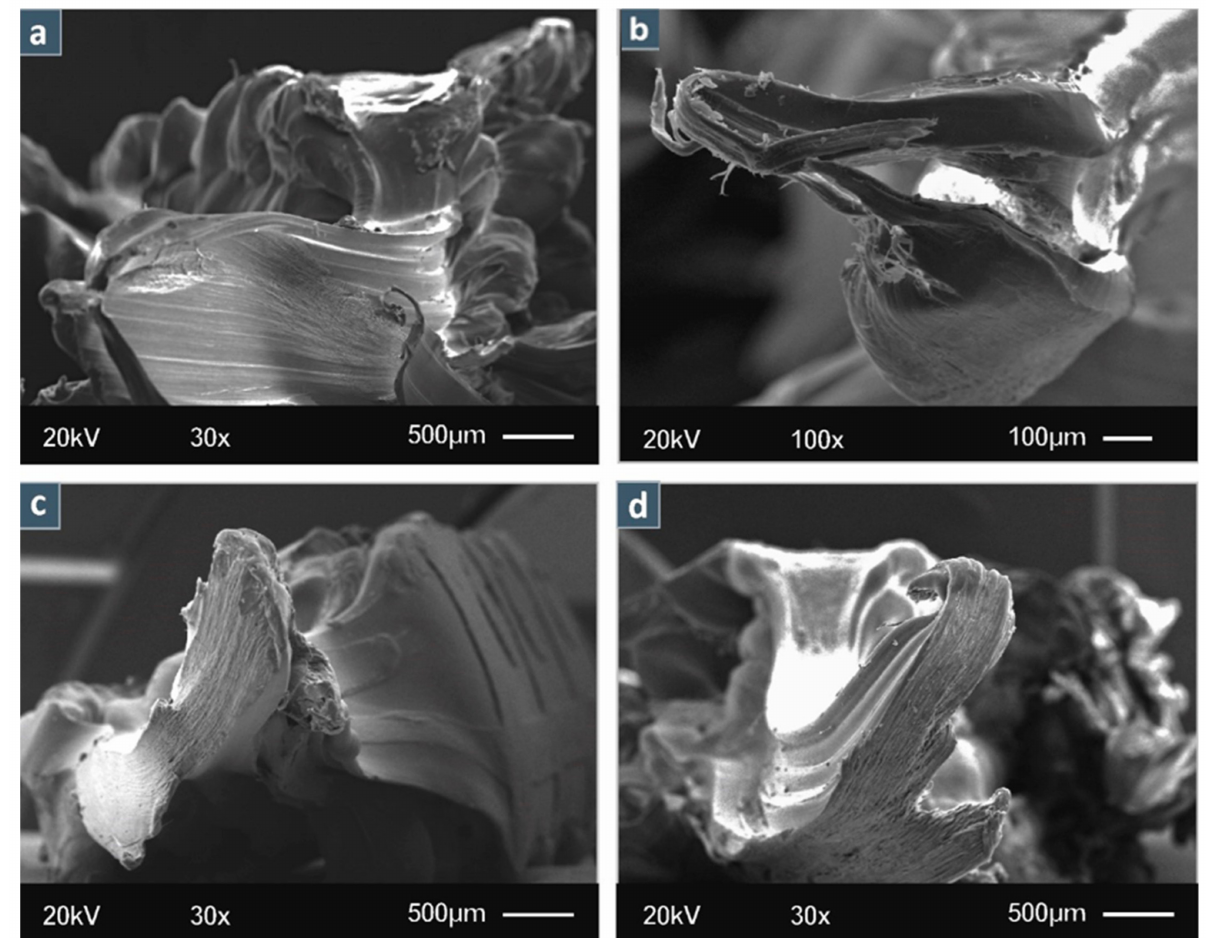
Figure 8. SEM images of ( a ) HDPE/TiO 2 0.5 wt.% materials’ printed specimen fracture area, ( b ) HDPE/TiO 2 2.5 wt.% materials’ printed specimen fracture area; ( c ) HDPE/TiO 2 5 wt.% ma- terials’ printed specimen fracture area; ( d ) HDPE/TiO 2 10 wt.% materials’ printed specimen fracture area. Note that the selected specimens are random tensile specimens in each